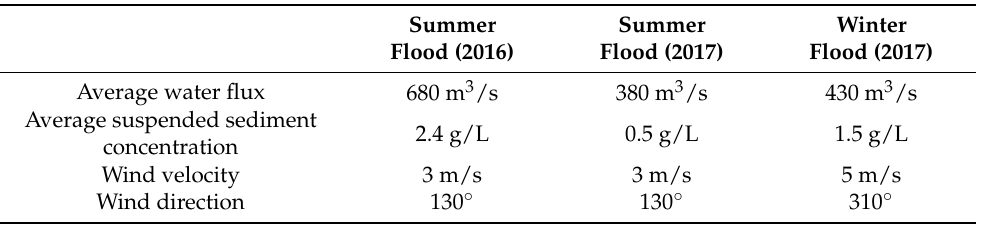
Table 1. Average values of water, sediment fluxes, and wind velocity in the Yellow River during the summer flood periods in 2016 and 2017 and the winter flood period in 2017.